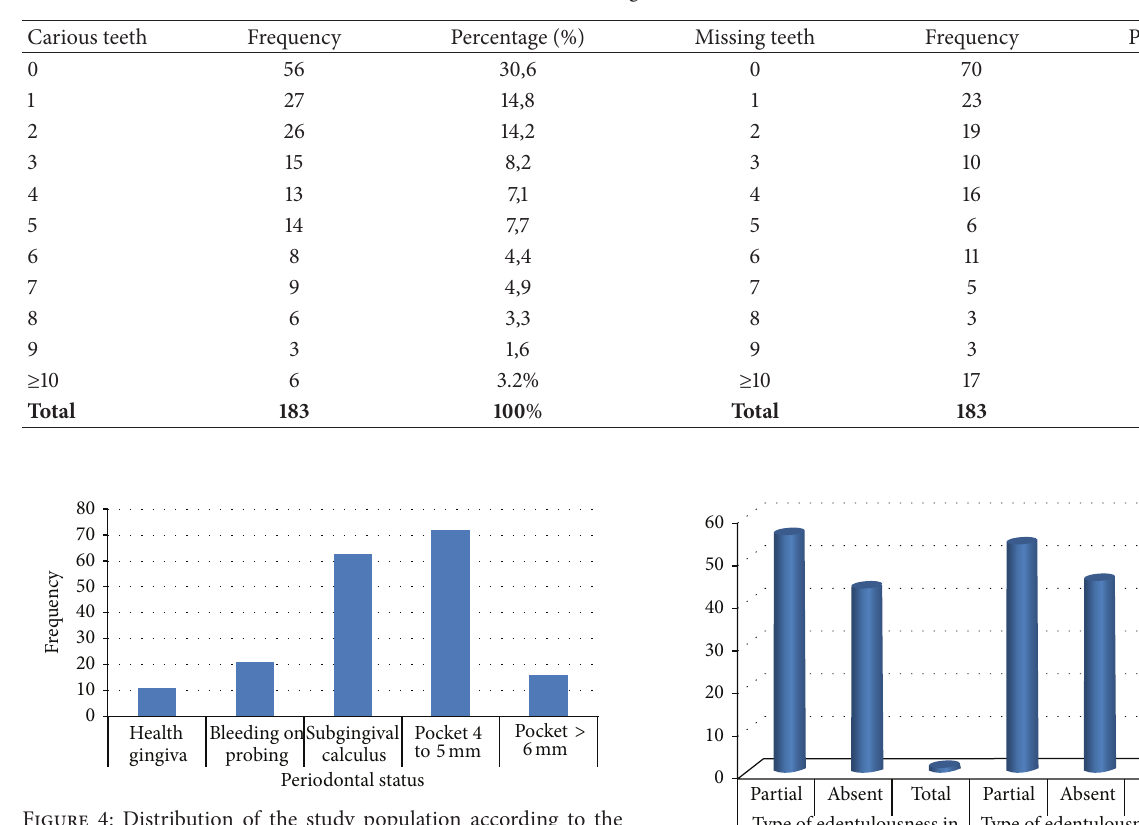
Table 4: Pathologies related to caries.